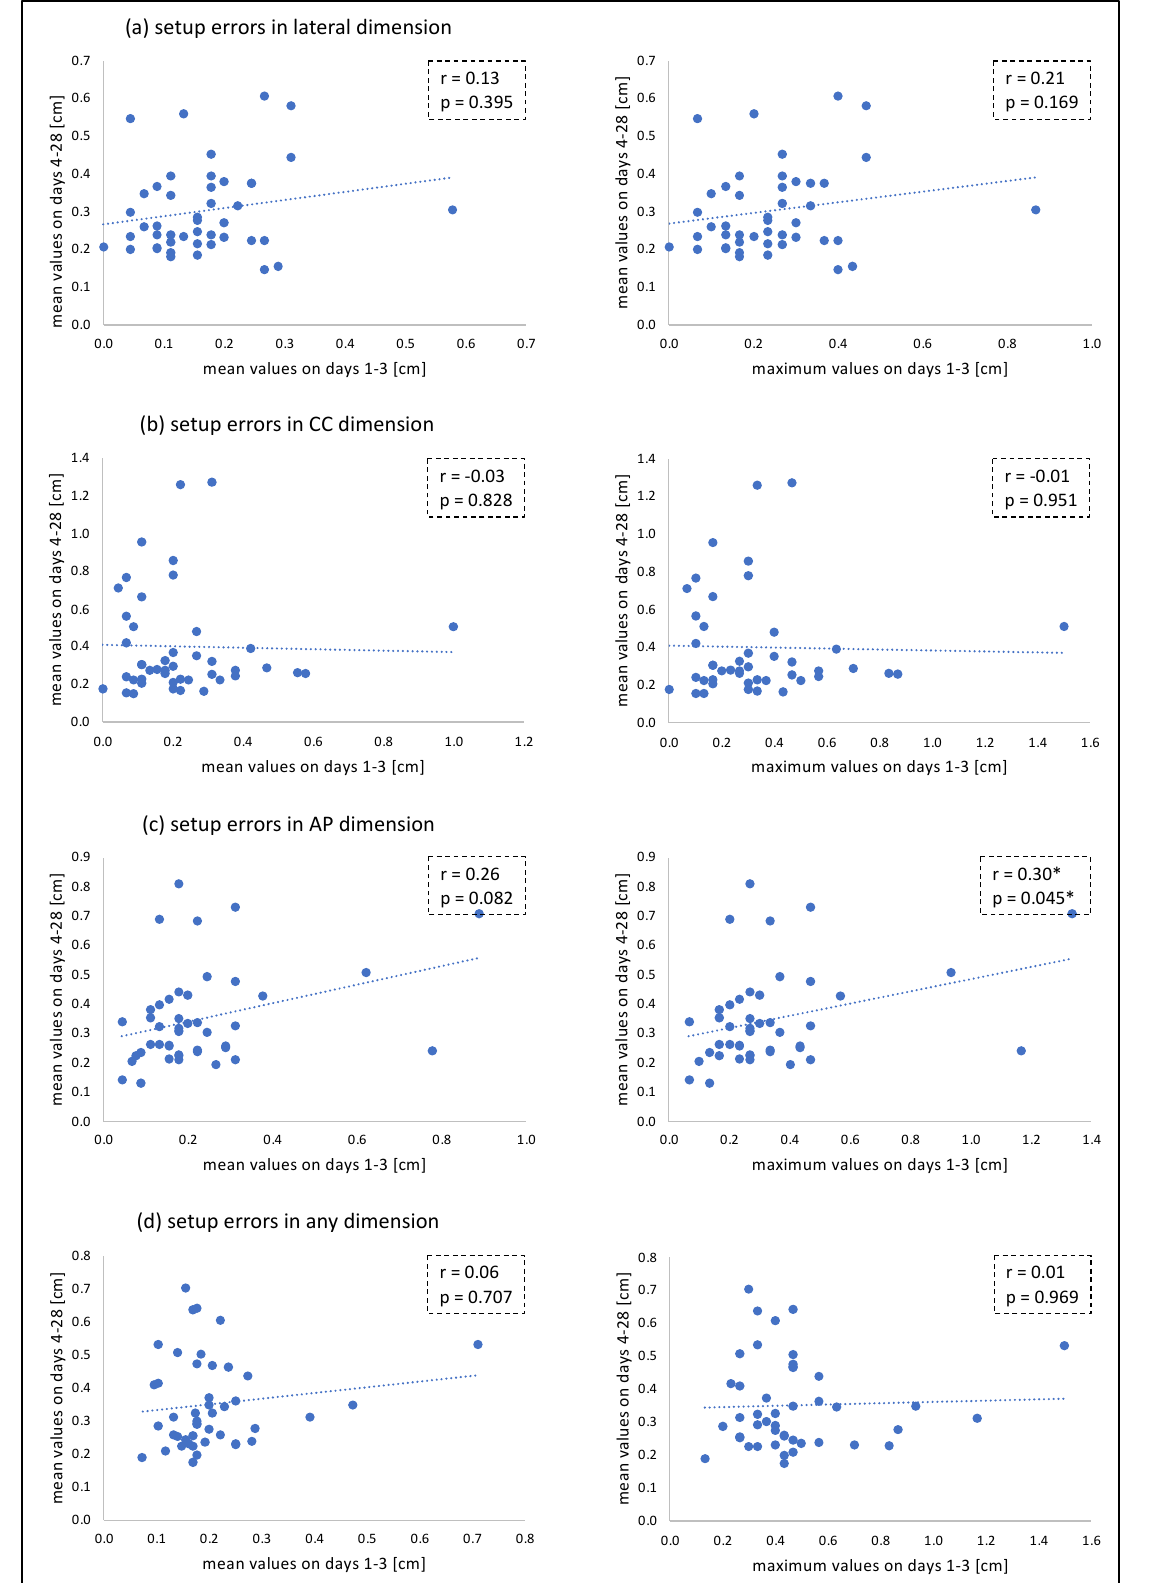
(d) setup errors in any dimension